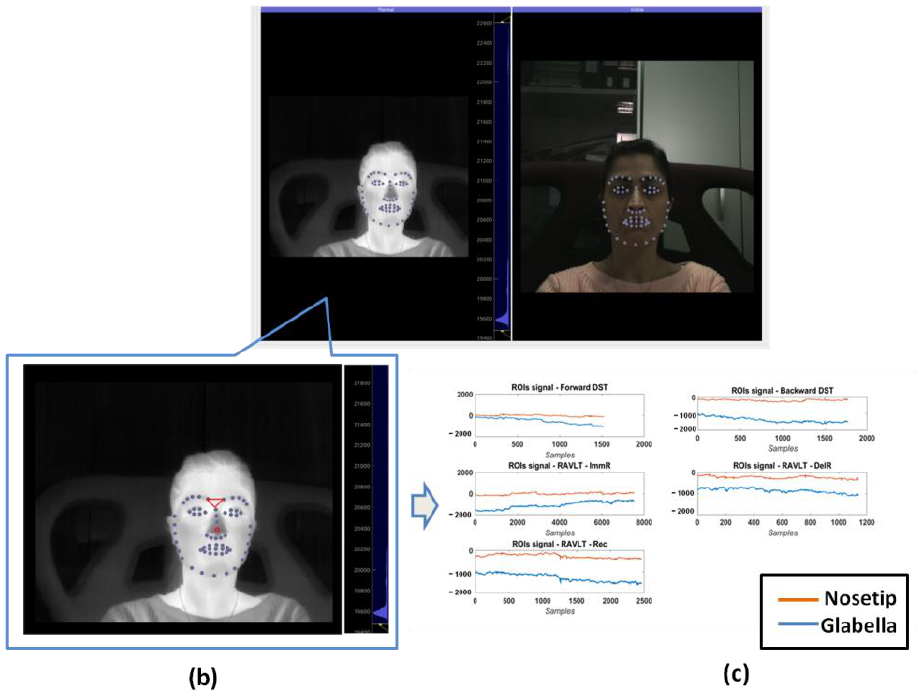
Figure 4. Processing of thermal and visible videos. ( a ) Software interface for the acquisition and processing of visible and thermal IR videos. ( b ) Thermal image with ROI drawn in red colors (Nosetip and Glabella); ( c ) thermal signal extracted from the two ROIs during the experimental phases. The values are obtained subtracting the mean value of the signals during the baseline phase.